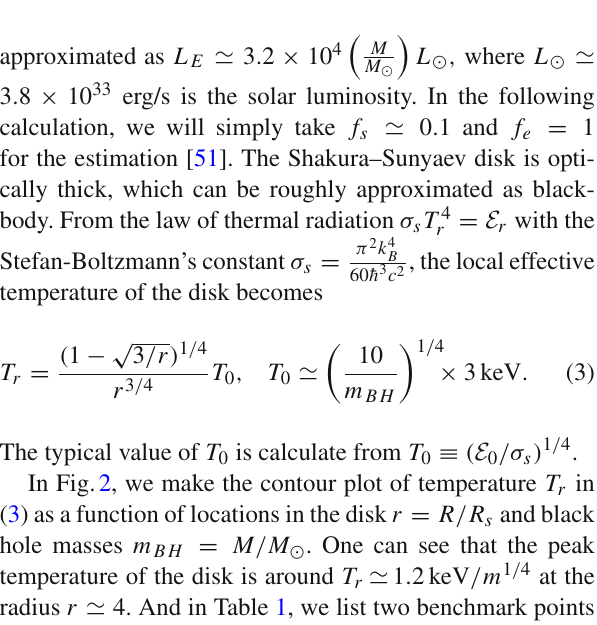
approximated as L E (cid:4) 3 . 2 × 10 4